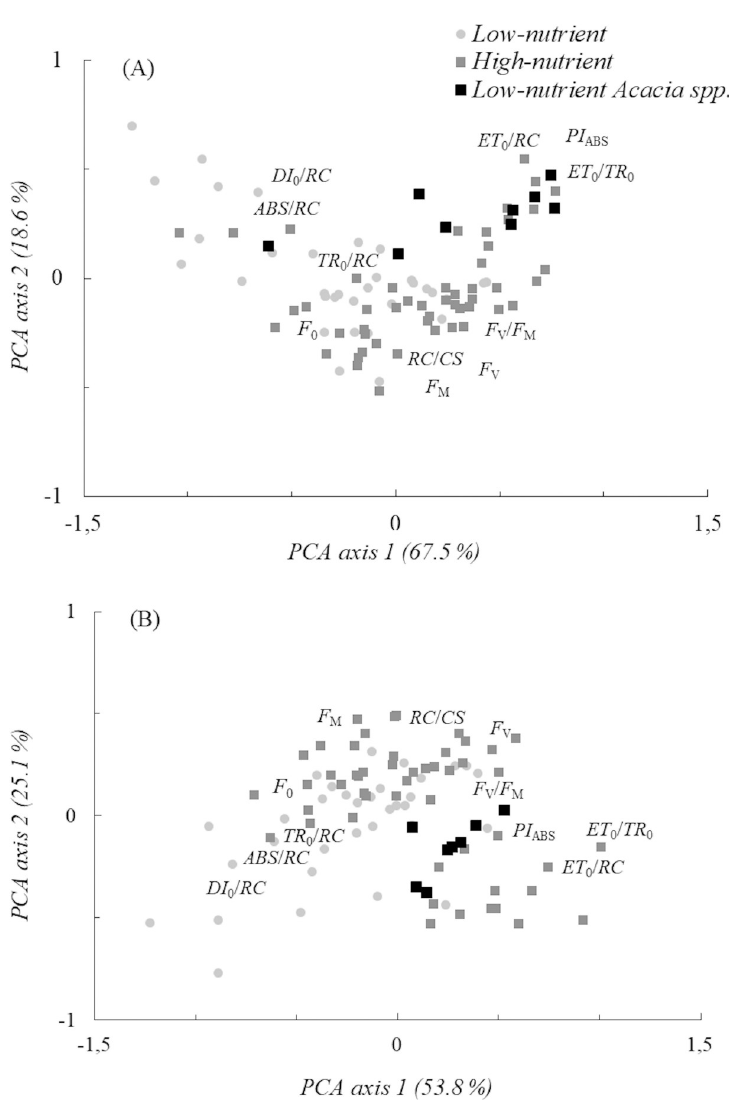
Fig 3. PCA ordination of fertilization effects during the wet (A) and dry (B) seasons. F 0 , initial, F M , maximum and F V , variable fluorescences; F V / F M , maximum quantum yield; PI ABS , performance index; ET 0 / TR 0 , efficiency of electron transport; DI 0 / RC , energy dissipation; ABS / RC , antenna size; ET 0 / RC , electron transport flux; TR 0 / RC , maximum trapped exciton flux; RC / CS , density of reaction centers per cross-section. ChF variables are approximately placed according to the product-moment (correlation loading) values along both PCA